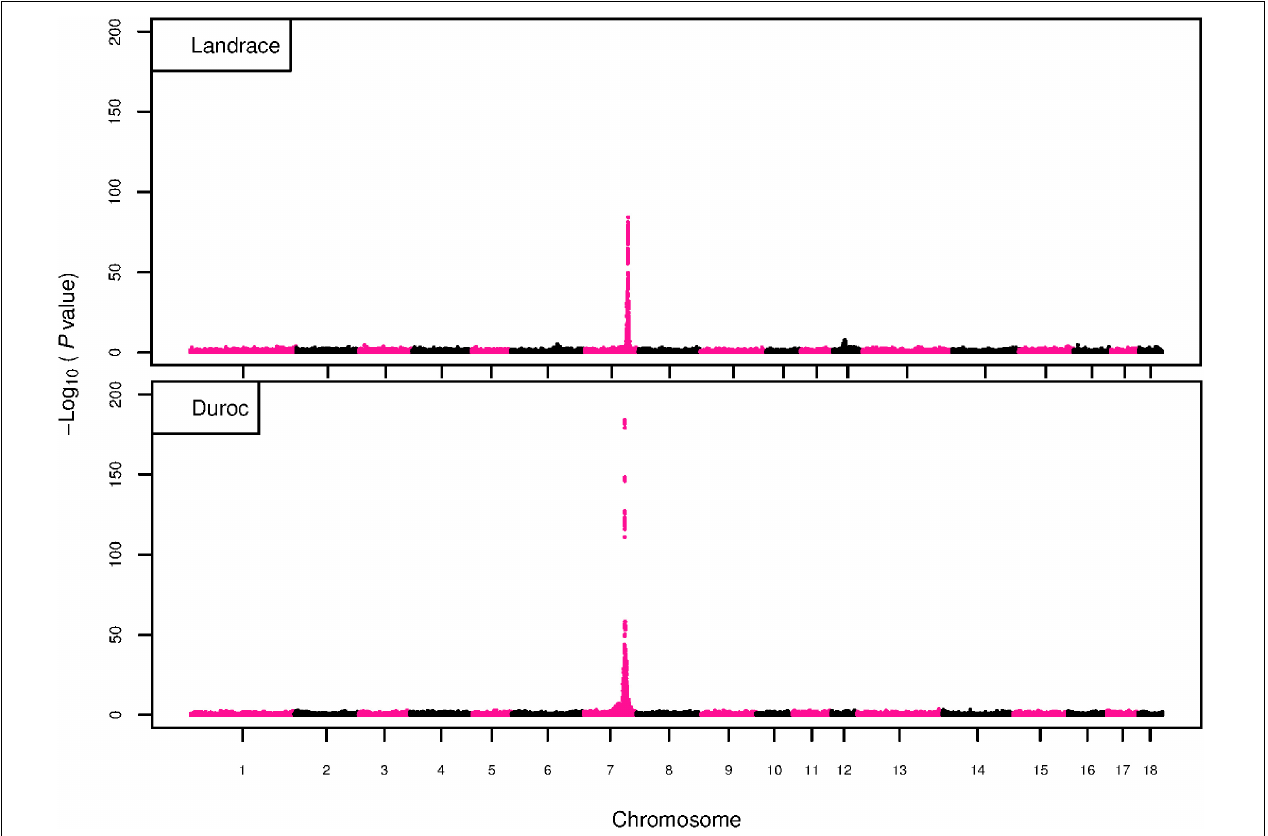
FIGURE 4 | GWAS plot for total NVE with imputed 660K SNP chip data. On the y -axis is the –log 10 ( p -values) of single SNP association with NVE in L and D breeds. On the x -axis is the physical position of the SNP across the 18 autosomes.